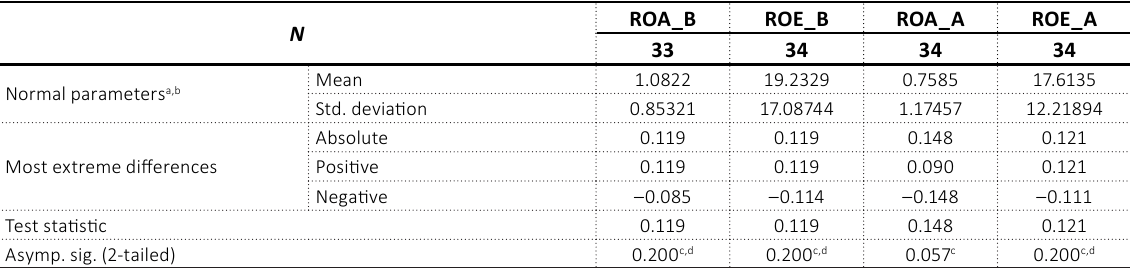
Table 2. One-sample Kolmogorov-Smirnov